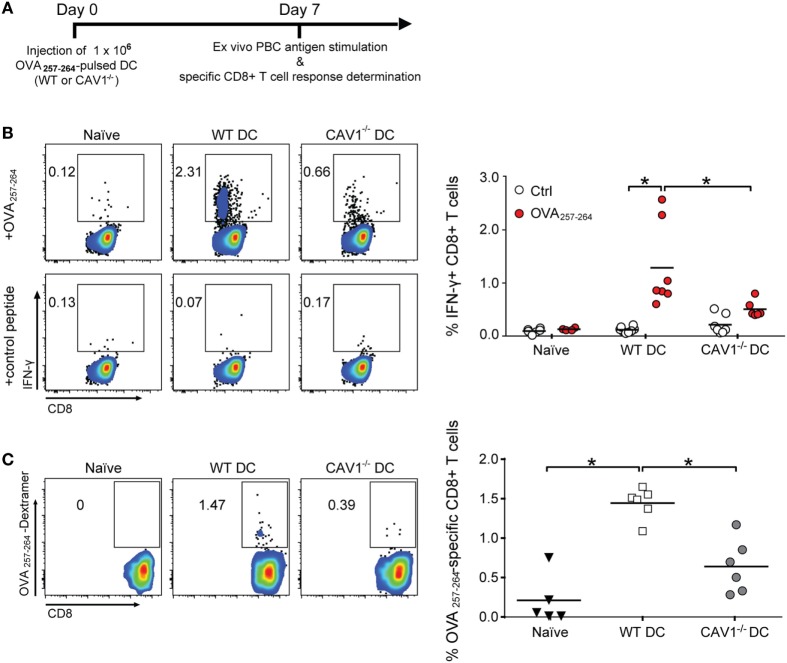
Caveolin-1 (CAV1) promotes the ability of dendritic cells (DCs) to induce antigen-specific CD8+ T cell responses. (A) Scheme of the experimental procedure. At day 0, 1 × 106 OVA257–265-pulsed wild-type (WT) or CAV1−/− bone marrow-derived DCs (BM-DCs) were transferred to recipient WT mice. After 7 days, blood samples were taken, and CD8+ T cell responses were analyzed. (B) Cells were stimulated with control (trp2180–188) or OVA257–265 peptides for 2 h, and then brefeldin A-containing solution (Golgi plug) was added for another 6 h (8 h total stimulation). Afterward, cells were stained and analyzed by flow cytometry. Representative dot plots of IFN-γ expression on gated CD3++CD8+ T cell population and the percentage of IFN-γ-producing CD8+ T cells are shown. Bars are the mean ± SEM (*p < 0.05, n = 7 mice, from two independent experiments). (C) Freshly isolated cells were stained with H-2 Kb/SIINFEKL (OVA257–265 peptide) dextramer to determine antigen-specific CD8+ T cells. Representative density plots and quantification of frequency of dextramer-positive from totalCD3+CD8+ T cell population are shown. Data are the mean ± SEM (*p < 0.05, n = 5–6 mice from two independent experiments).